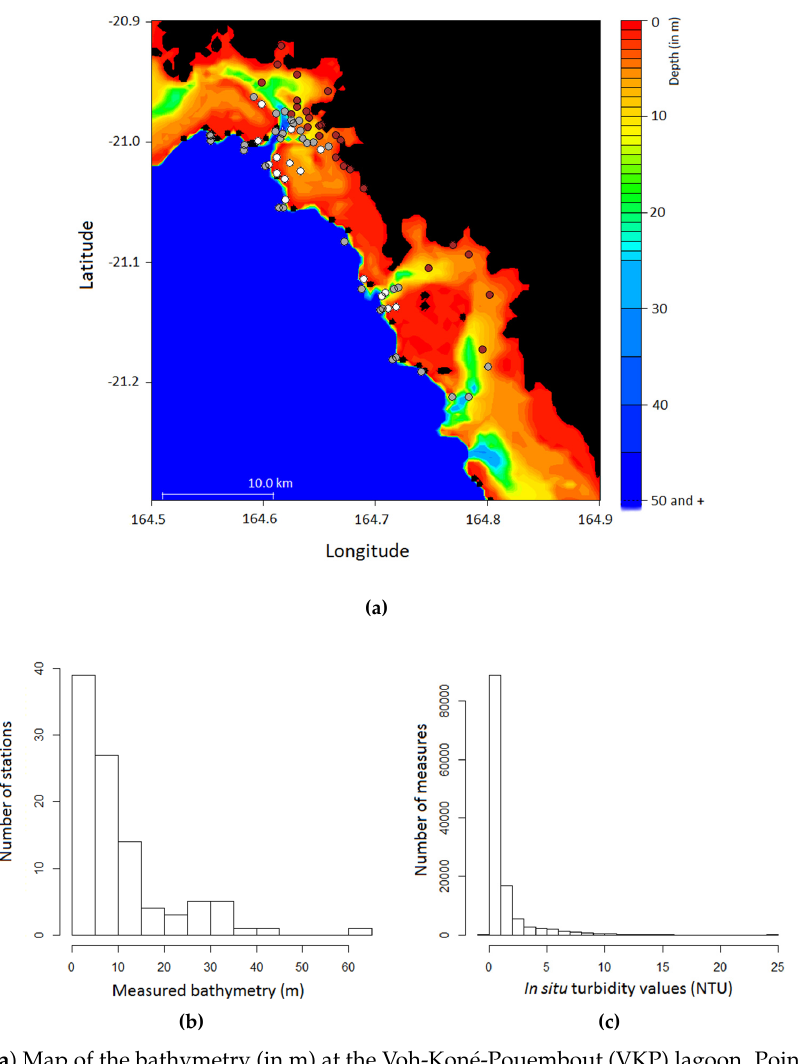
Figure 2. ( a ) Map of the bathymetry (in m) at the Voh ‐ Koné ‐ Pouembout (VKP) lagoon. Points colours correspond to bottom colour, i.e. : white bottom; : grey bottom; : brown bottom; black areas correspond to land and those near the barrier reef are emerged reefs. ( b ) Histogram of the measured bathymetry on the visited stations. ( c ) Histogram of the in-situ turbidity values measured along CTD